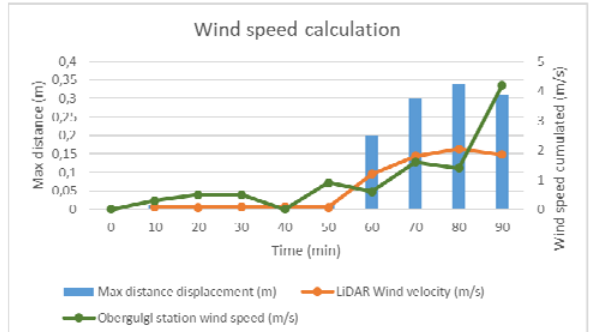
Figure 6. Wind regime near the scan location (green graph) compared to the maximal displacement w.r.t. a reference epoch (blue graph). Larger wind speeds near the end of the experiment correspond to larger displacements in the scan data.